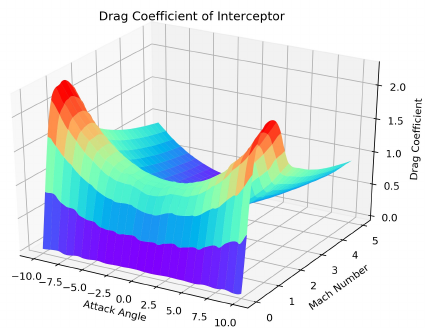
Figure 2. Drag coefficient.